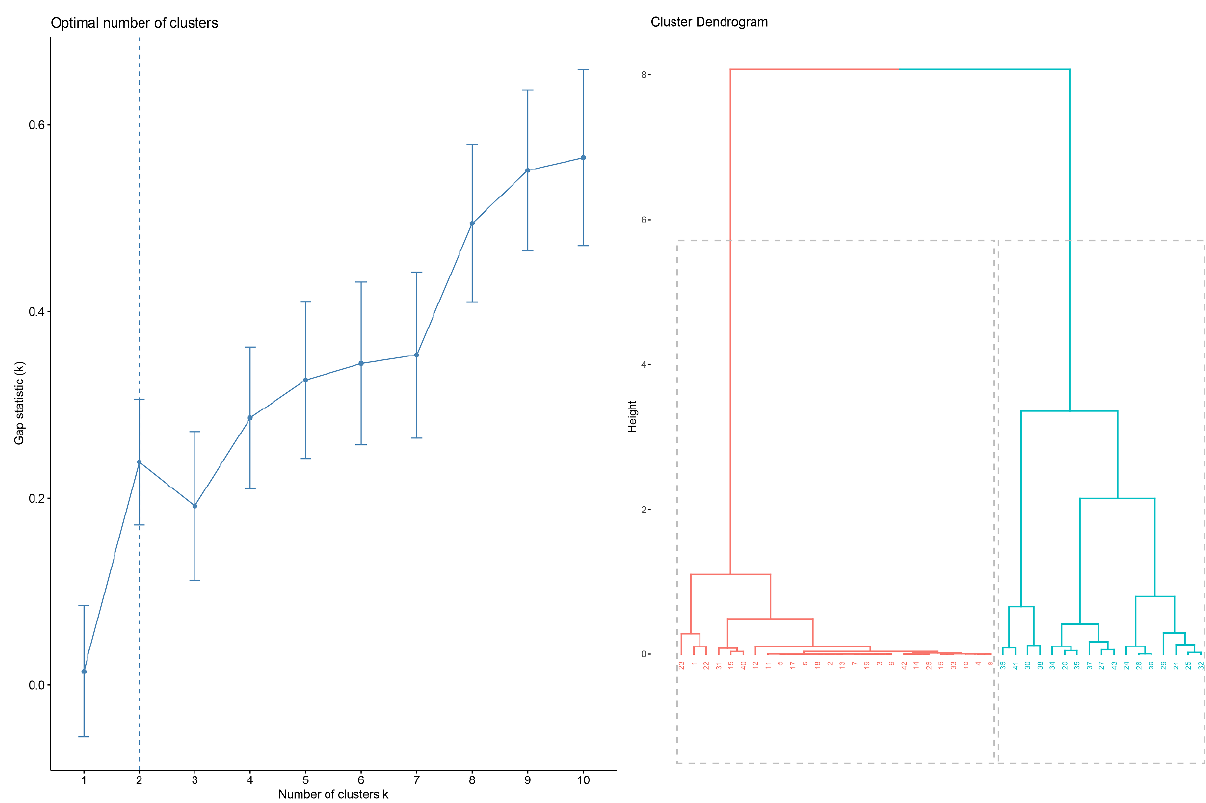
Figure 2. Cluster analysis. ( left ) The optimal number of clusters; ( right ) dendrogram illustration of hierarchical clustering.